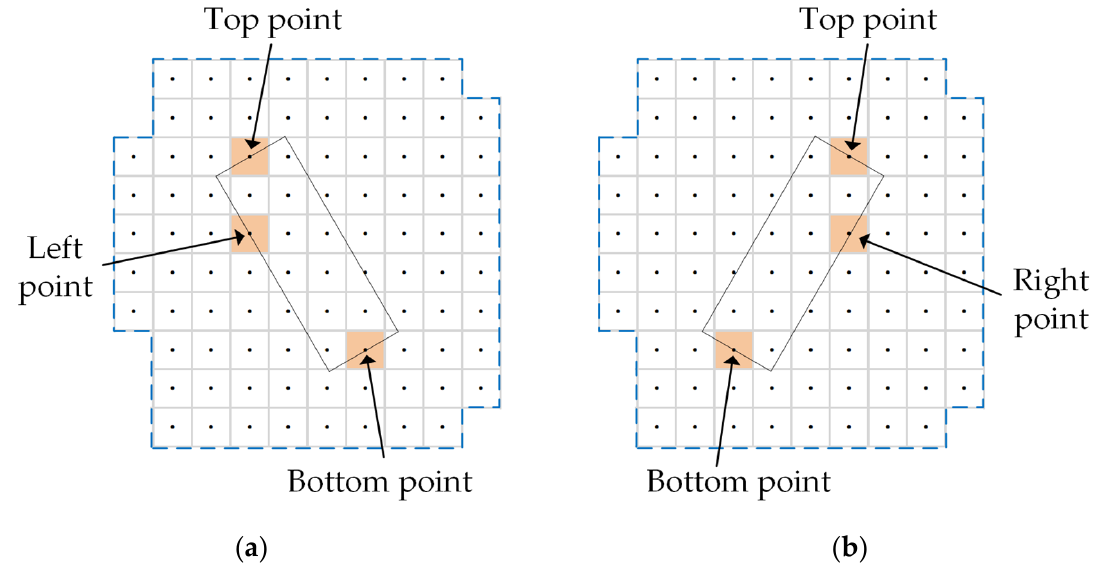
Figure 5. Candidate strip based on grid. ( a ) Ascending; ( b ) descending. Algorithm 1 Candidate strip generation algorithm.